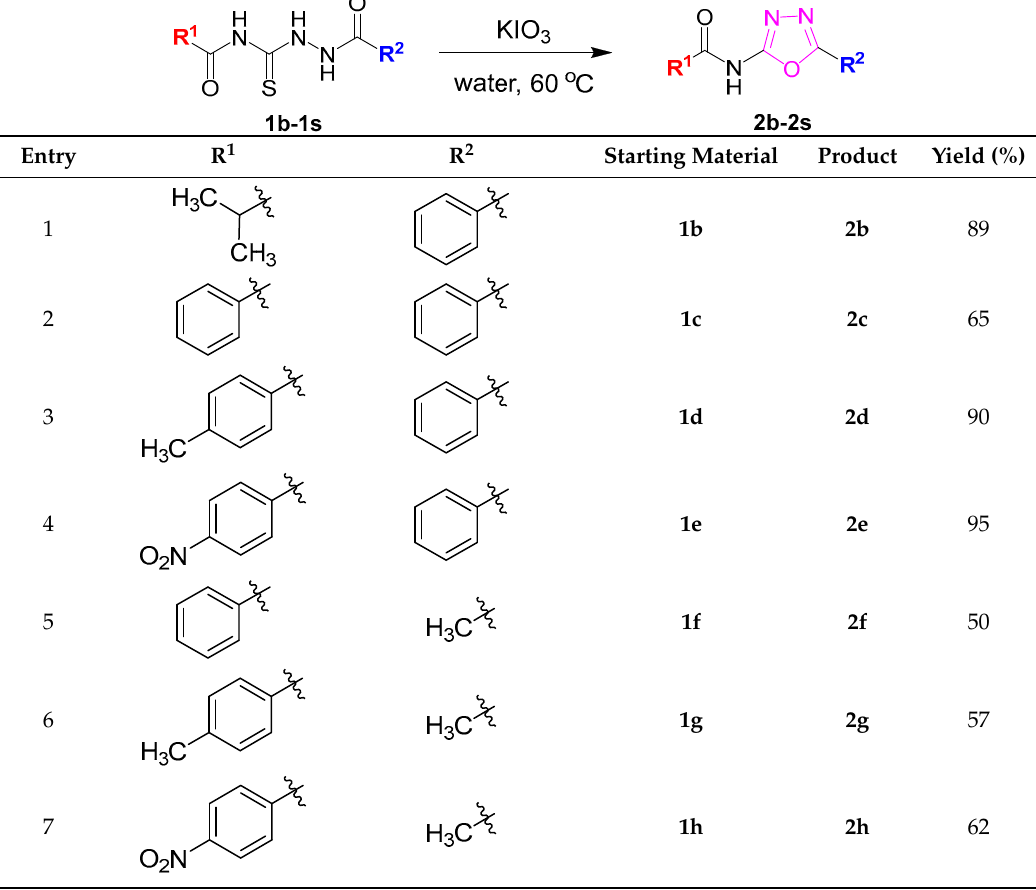
Table 2. Reaction scope of cyclization of the thiosemicarbazide.